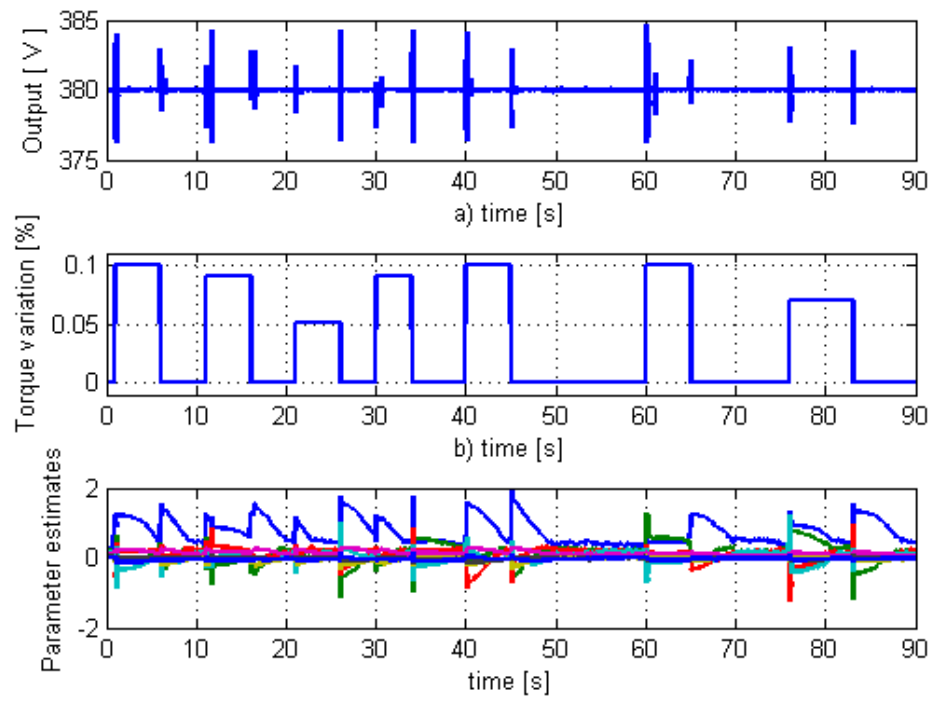
Figure 13. Resistive load—3rd order model: ( a ) Terminal voltage (controlled output); ( b ) Excitation voltage (controller output).